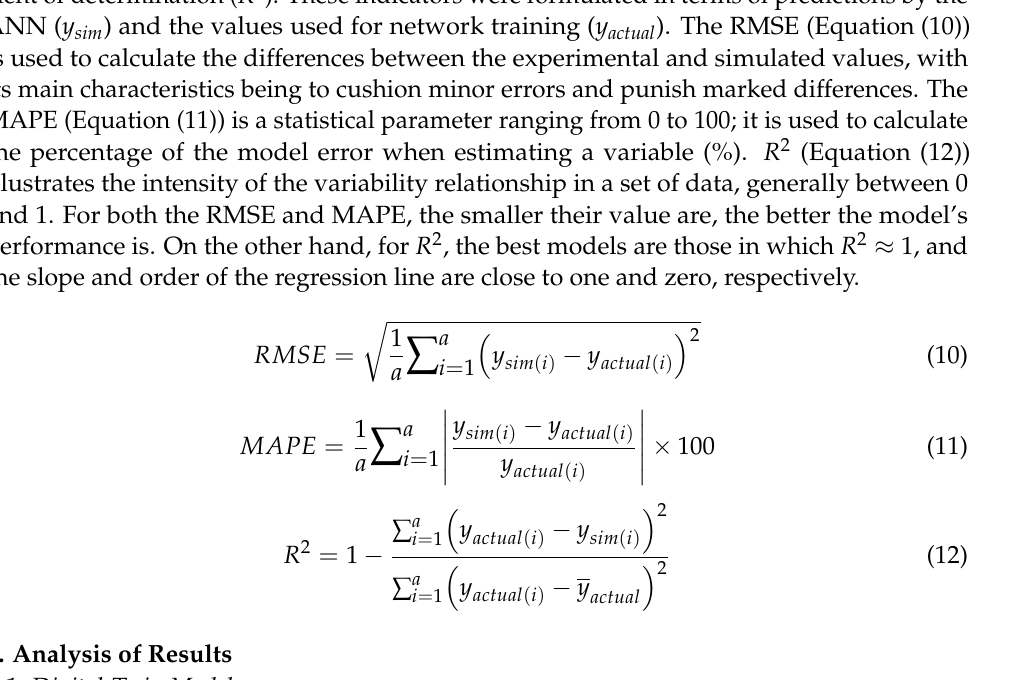
Table 6. Hyperparameters assigned to the ANN during the training phase for the development of the predictive model. Hyperparameter Description Number of epochs 500 Batch size Full batch Performance goal 1 × 10 − 20 Validation faulers 10 Performance gradient 1 × 10 − 7 Time out ∞ Initial µ 0.001 Maximum µ 1 × 10 10 Cross-validation 10 Performance function Mse Weights and bias initializer